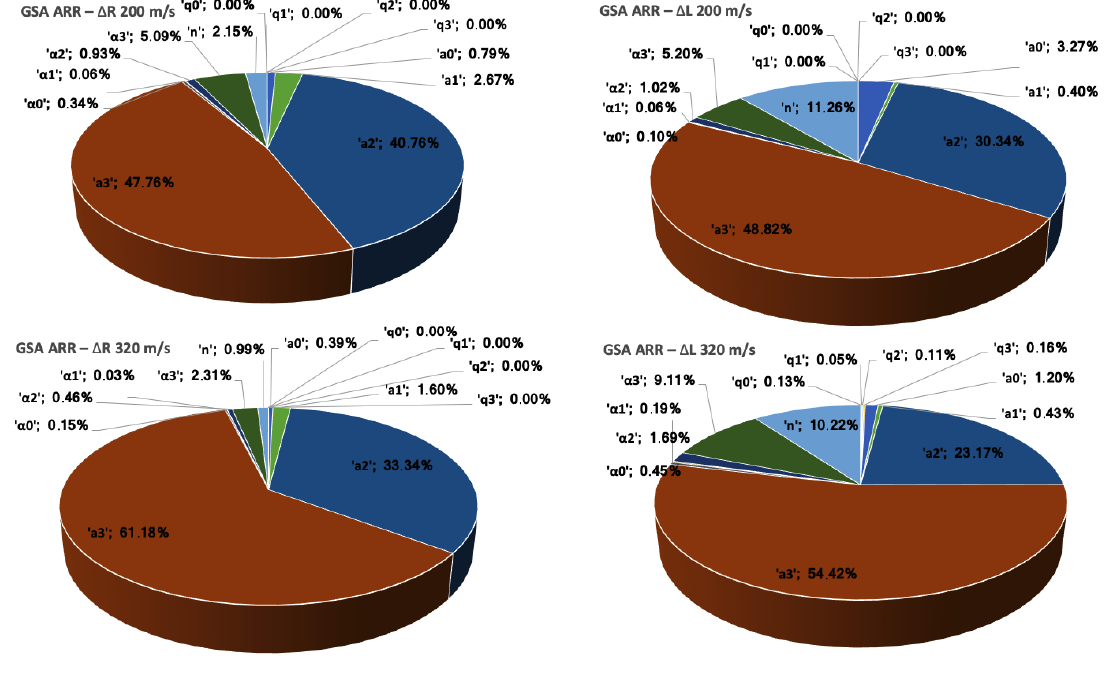
Figure 9. GSA results for the Arrhenius-type model considering ∆ R and ∆ L at 200 and 320